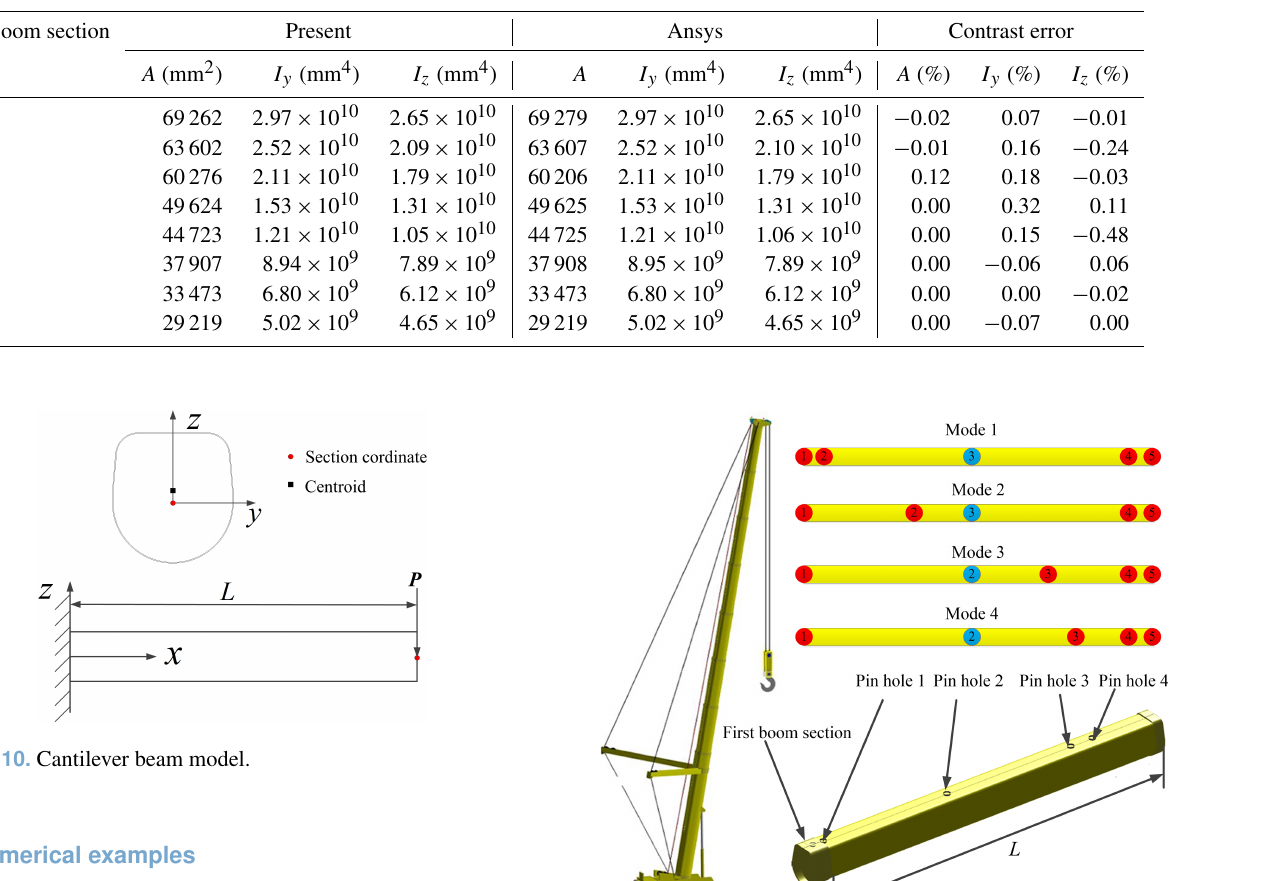
parameters of each boom section, and the section moment of